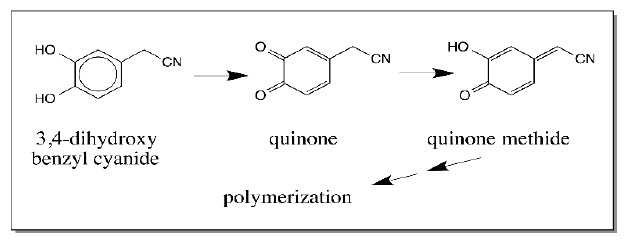
Figure 13. Oxidative transformation of 3,4-dihydroxybenzyl cyanide. 3,4-Dihydroxybenzyl cyanide upon oxidation to its quinone undergoes rapid isomerization to quinone methide, which readily polymerizes to uncharacterized products.